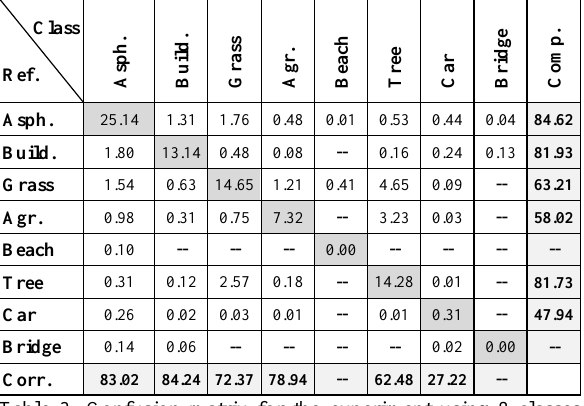
Table 3: Confusion matrix for the experiment using 8 classes and the car confidence feature. All values are given in [%]. Overall accuracy: 74.84%. Asph: asphalt . Class Ref. Asph.